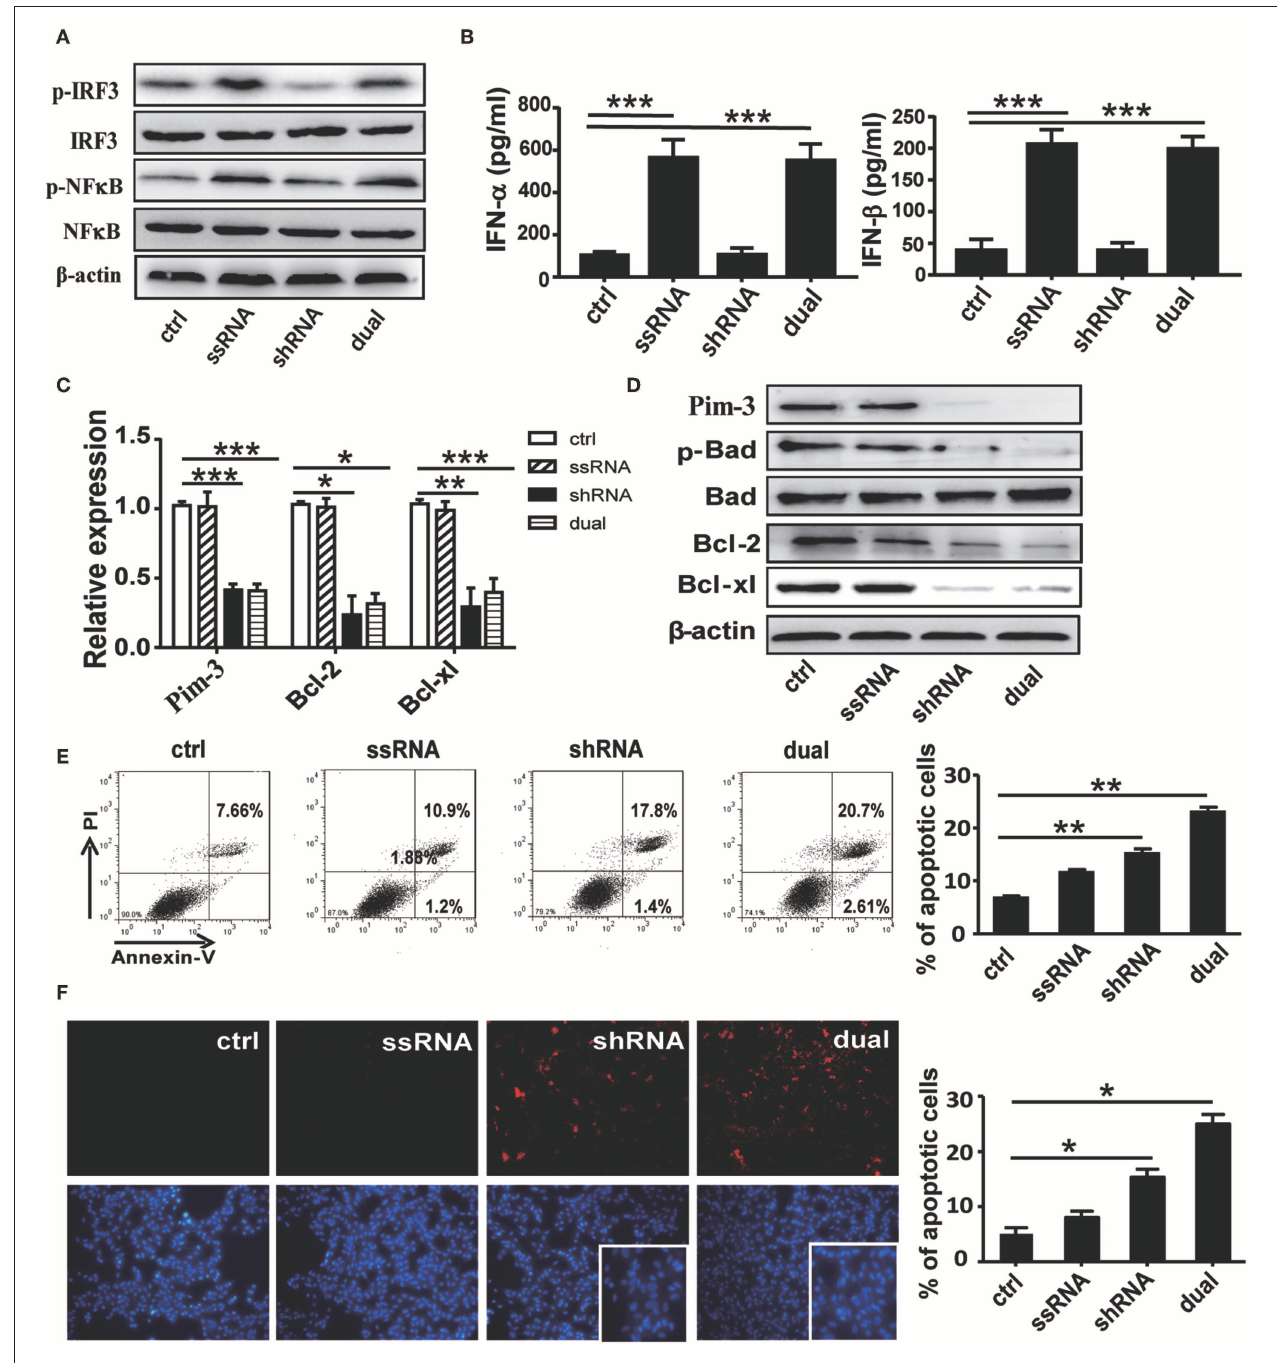
FIGURE 1 | Functional verification of dual-function vector. B16F10 cells transfected with pSIREN (ctrl), ssRNA, sh-Pim-3, or dual-function vector for 24h. (A) Western blot detection of p-IRF3, IRF3, p-NF- κ B, NF- κ B, and β -actin protein expression. (B) Supernatant levels of IFN- α and IFN- β detected by ELISA. (C) Gene analysis of Pim-3, Bcl-xl, and Bcl-2 via qRT-PCR in B16F10 cells after transfection for 24h with the indicated vectors. (D) The protein levels of Pim-3, p-Bad, Bcl-xl, and Bcl-2 measured by Western blotting. (E) Flow cytometric analysis of apoptosis in B16F10 cells after transfection for 24h with indicated vectors using annexin V/PI double staining. (F) TUNEL staining to evaluate apoptosis of B16F10 cells after transfection for 24h. Blue fluorescence represents nuclei, and arrowhead indicates shrinking nuclei. Data are representative of three independent experiments. * P < 0.05, ** P < 0.01, and *** P < 0.001 vs. control group. ssRNA, single-stranded RNA; IFN, interferon; PI, propidium iodide; TUNEL, terminal deoxynucleotidyl transferase-mediated dUTP nick-end labeling.